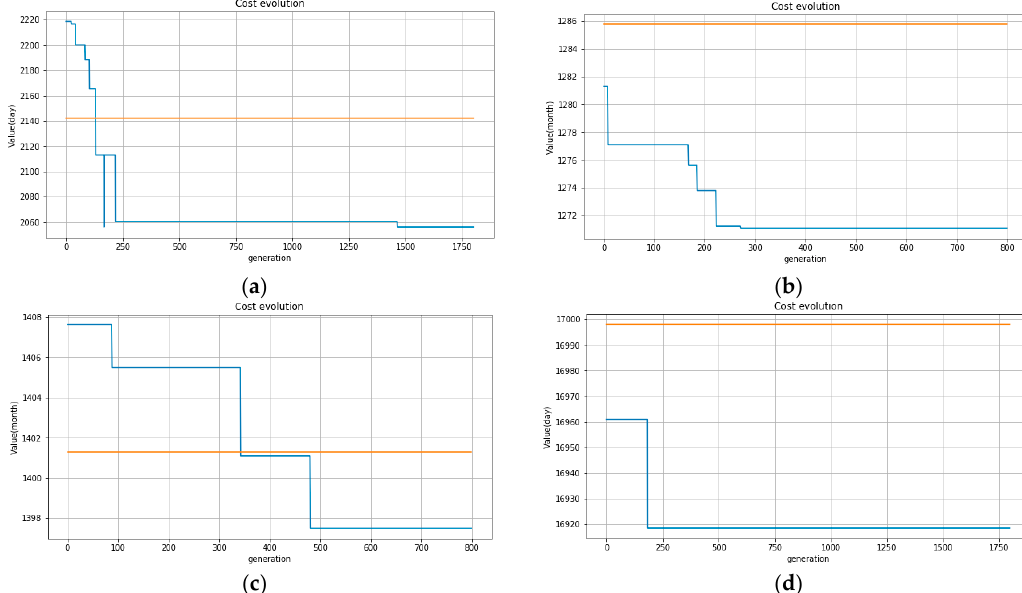
Figure 10. Cost evolution by running the GA for consumers with different numbers of devices: 20 ( a ), 40 ( b ), 60 ( c ), and 80 ( d ).